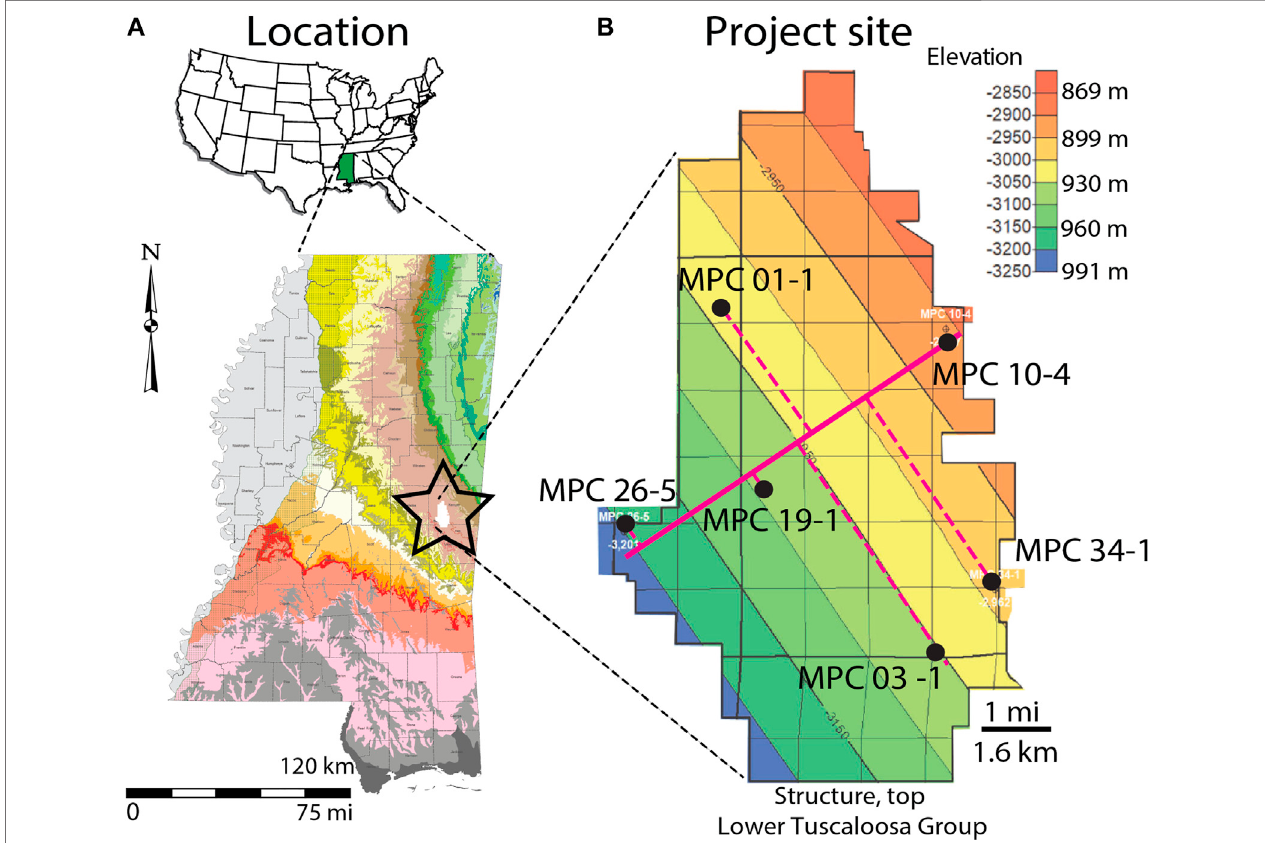
FIGURE1| Locationofstudyarea. (A) MapshowingtheKemperCountyenergyfacilityineast-centralMississippi. (B) Structuralcontourmapofthetopofthelower Tuscaloosa Group showing locations of six exploratory boreholes and line of cross section (after Pashin et al., 2021).